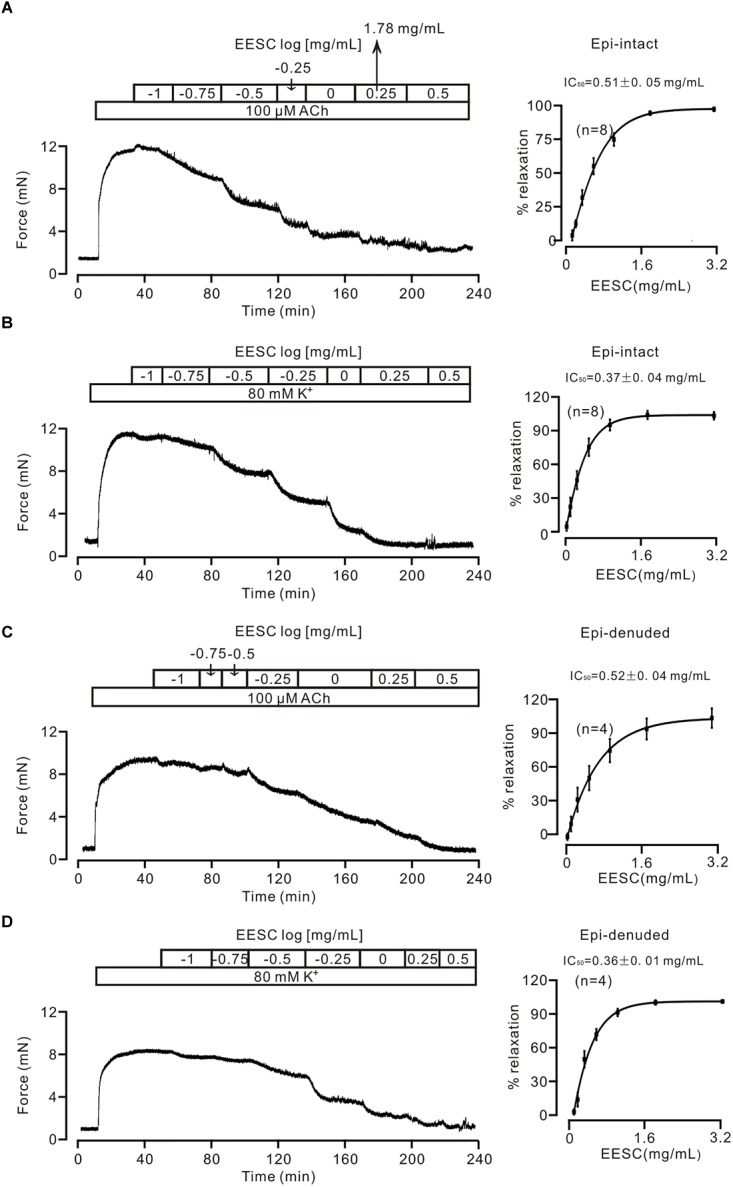
EESC blocks contraction in mouse TRs. (A) ACh (100 μM) induced a sustained contraction in a mouse TR, which was blocked by EESC. The dose-inhibition curve is presented. (B) Similar experiments were performed, except that the TR contraction was induced by 80 mM K+. (C,D) The same experiments as above performed in epithelia-denuded TRs. These data indicate that the EESC blocks ASM contraction.